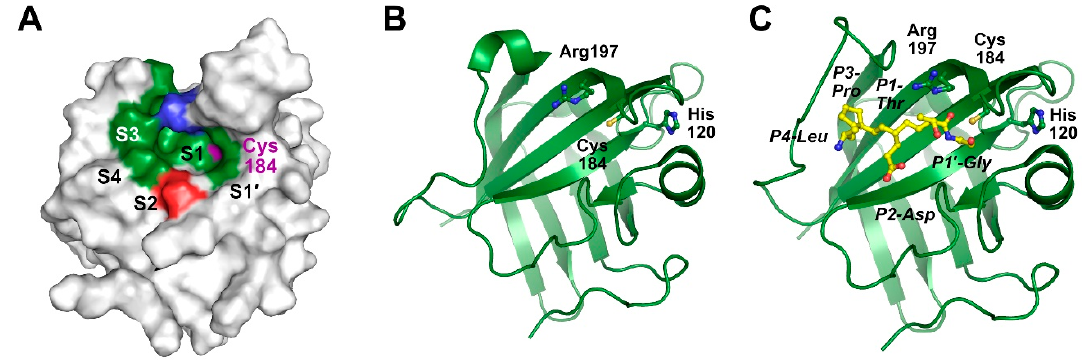
Figure 5. Sortase ligases. ( A ) Sortase A surface representation, derived from the first NMR structure (PDB 1IJA). The non-prime side of the active site is dominated by hydrophobic residues (green), less by basic (blue) and acidic (red) ones, whereby the catalytic Cys184 is shown in purple. ( B ) Ligand-free sortase A (PDB 1T2P). The most important catalytic residues are labeled: the nucleophile Cys184, its dyad partner His120, and Arg197. ( C ) Sortase A substrate complex with the peptide LPETG bound to the active site of a Cys184Ala mutant (PDB 1T2W). The role of Arg197 as an equivalent to an oxyanion hole is corroborated by binding the carbonyl O of P1–Thr.